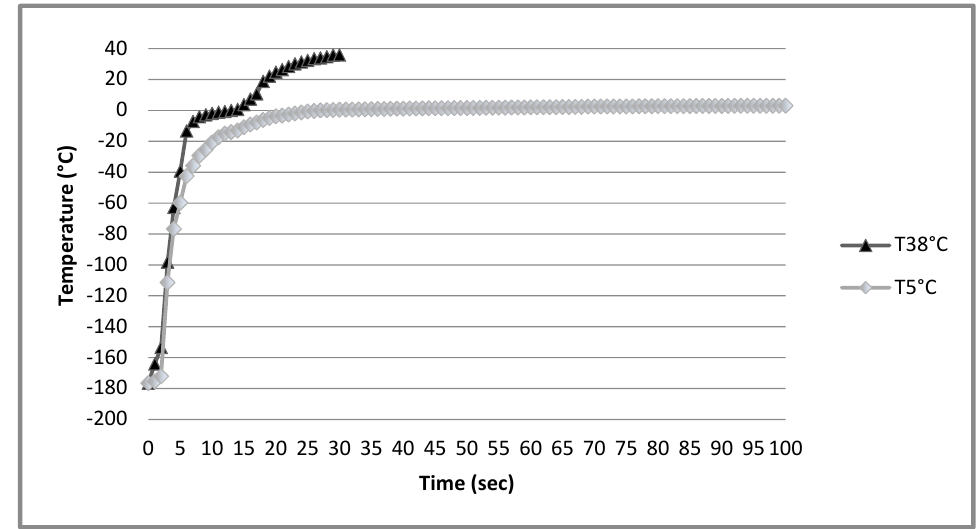
Figure 1. Change in temperature of chicken semen inside straws during thawing procedure according to different thawing rates.